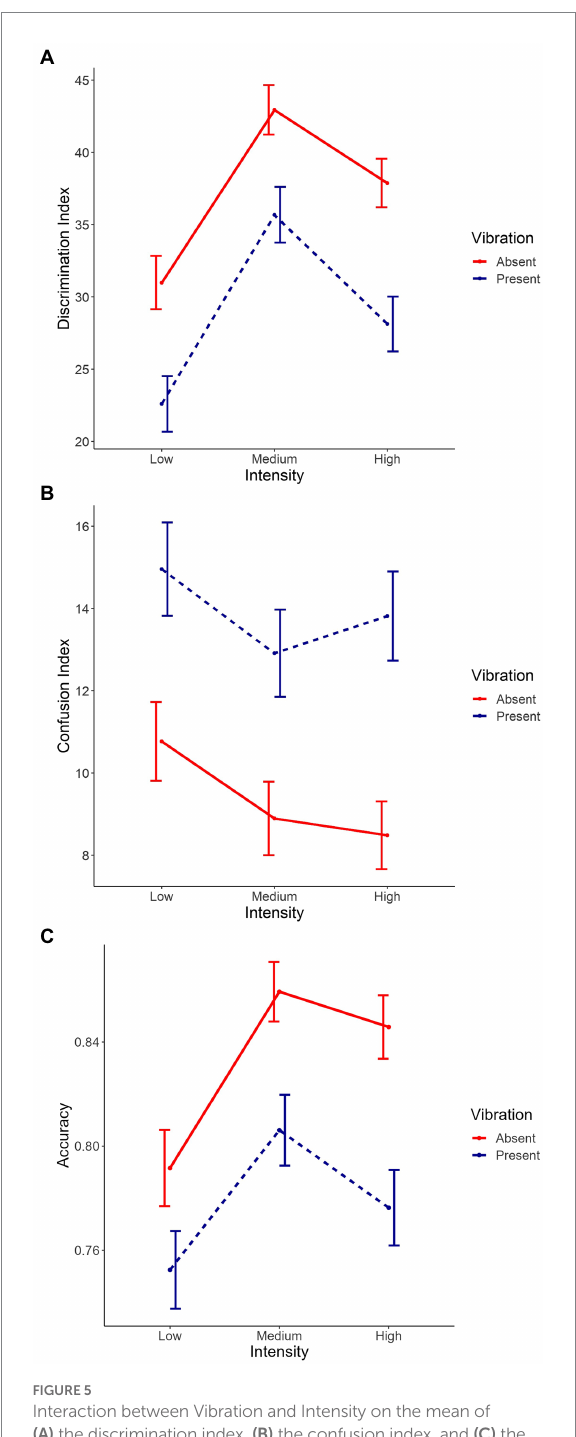
FIGURE 5 Interaction between Vibration and Intensity on the mean of (A) the discrimination index, (B) the confusion index, and (C) the accuracy. Intensity conditions are represented on the X axis (i.e., low, medium and high). Each line represents Vibration (i.e., absent, present). Error bars indicate the standard error of the